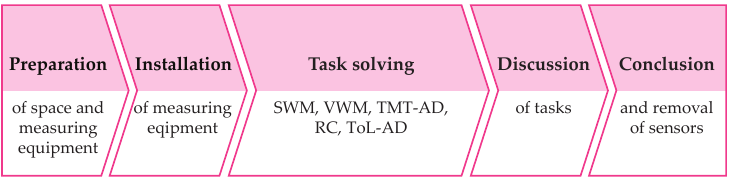
Figure 4. Measurement protocol.